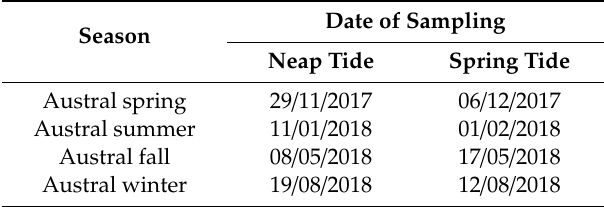
Table 1. Dates at which hydrographic transects were carried out along the central axes of the